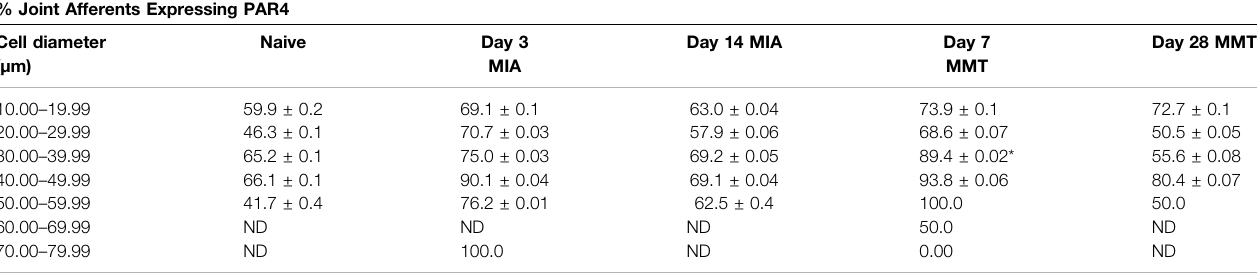
TABLE1| ComparisonofPAR4ExpressionbyNeuronalcellsize.ThedistributionofPAR4expressing fl uoro-golddorsalrootgangliawasquaniti fi edbasedoncelldiameter. Similar levels of PAR4 were observed within each model regardless of neuronal size. * p < 0.05 denotes statistical signi fi cance (2-way ANOVA) day 7MMT versus day 28 MMT. Data presented as means ± SEM. ND, not detected.